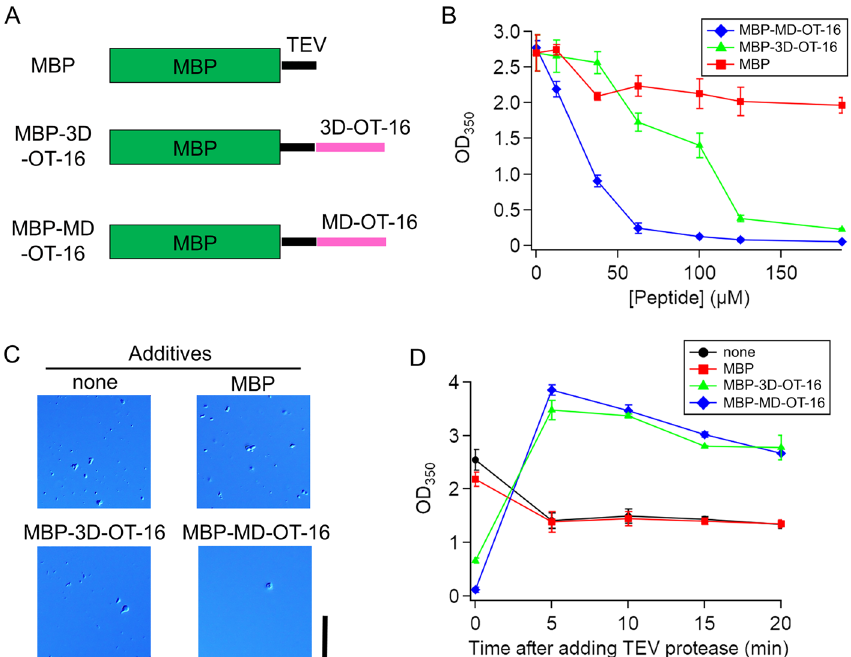
Figure 4. Soluble MBP-tag converts the designed peptide from an accelerator to a suppressor for p53 droplet formation. ( A ) Schematic illustration of primary sequences of the MBP-fused designed peptides and MBP used in this study. TEV represents the TEV protease cleavage sequence. The thick and thin bands correspond to folded and disordered regions, respectively. ( B ) Effect of the MBP-fused designed peptides or MBP as additives on p53 droplet formation detected as OD 350 . ( C ) DIC images of p53 solutions in the presence and absence of 125 µM MBP-fused designed peptides and MBP. Scale bar, 20 µm. These images were taken after 5 min of incubation of the p53 solutions with additives or without additive (none). ( D ) Time course of scattering (OD 350 ) from 12.5 µM p53 solutions after incubation in the presence of 125 µM MBP-fused designed peptides or MBP for 5 min and the subsequent addition of TEV protease. The data before adding TEV protease are plotted at 0 min. “None” denotes the absence of MBP-fused designed peptide or MBP additives as control. In ( B and D ), error bars represent standard error ( N =